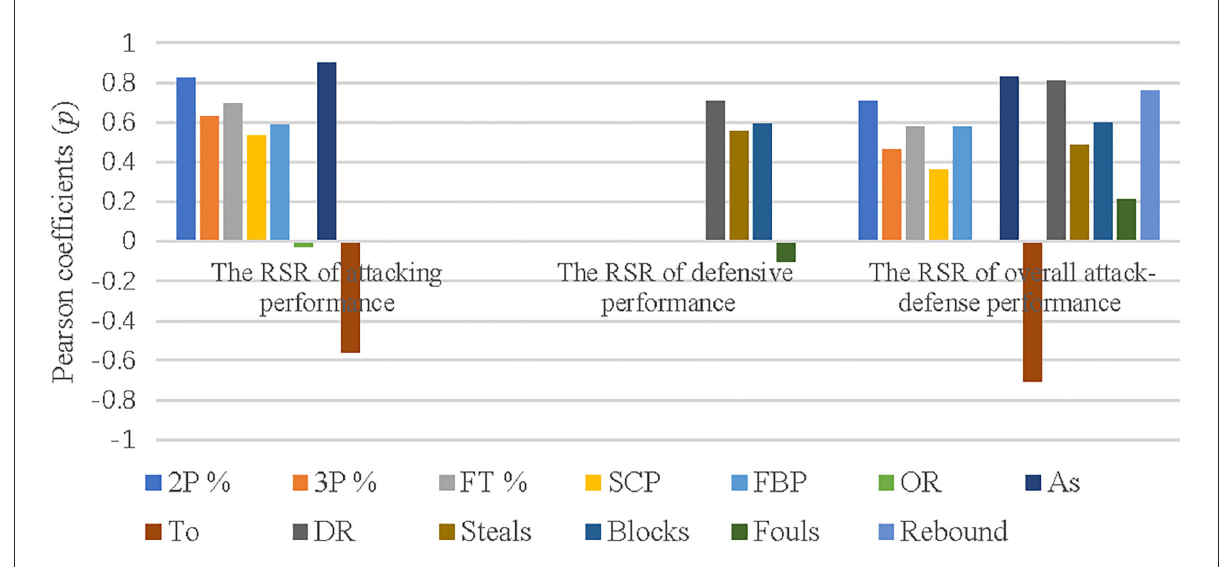
FIGURE2 Correlation between performance indicators and the attack-defense performance.